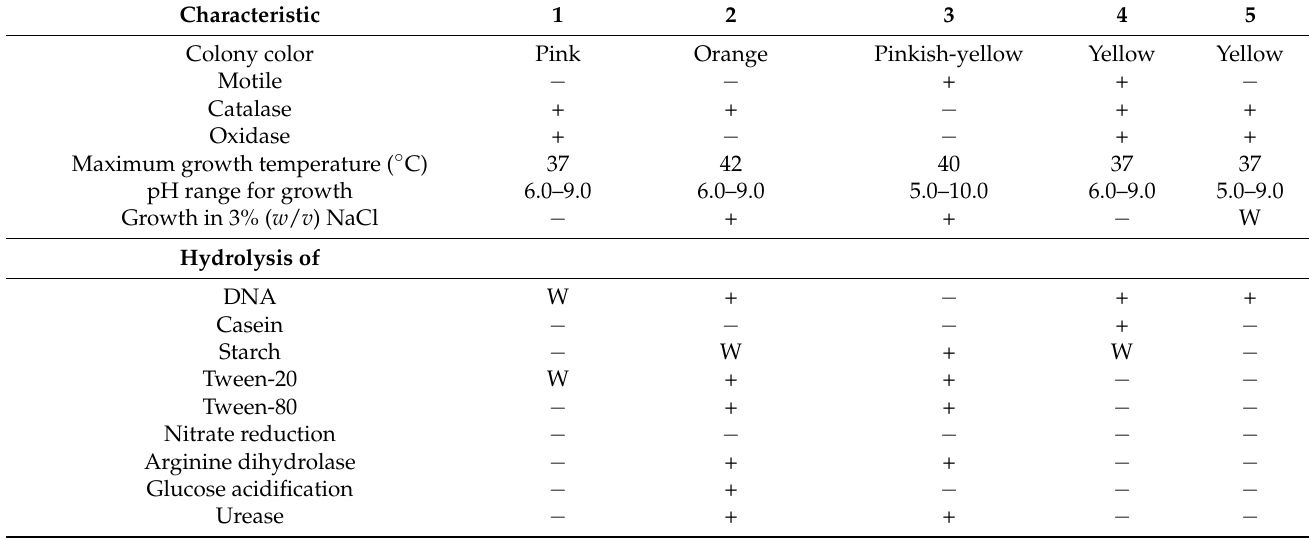
Table 1. Physiological characteristics of strain YL24-3 and related strains of species of the genus Pedobacter . Characteristic 1 2 3 Colony color Pink Orange Pinkish-yellow Yellow Yellow Motile − Catalase Maximum growth temperature ( ◦ C) 37 pH range for